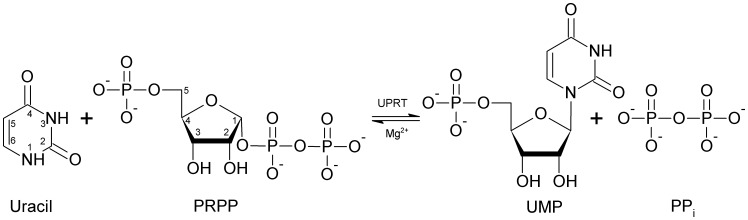
Chemical reaction catalyzed by MtUPRT.